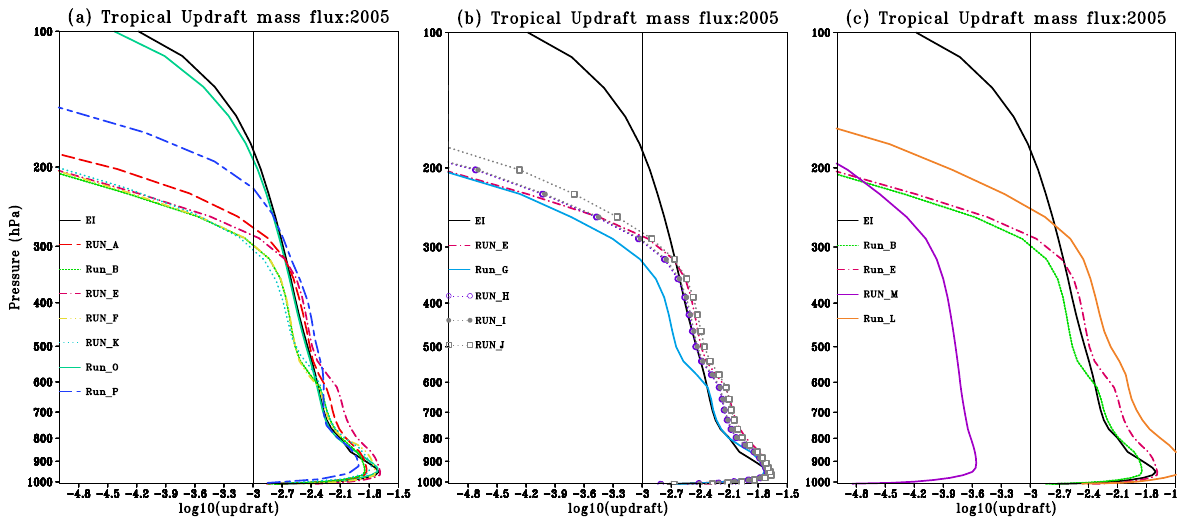
Fig. 7. Zonal mean annual mean tropical (25 ◦ S–25 ◦ N) updraft convective mass flux (kgm − 2 s − 1 ) for 2005 from ERA-Interim reanalyses and (a) runs “A E40”, “B EI”, “E EInewevap”, “F EInewconv”, “K L31”, “N 1991” (December 1990 to January 1991), “O EIar”, “P det”, (b) runs “E EInewevap”, “G 5.6”, “H 1.1”, “I 1.4”, “J T106”, and (c) runs “B EI”, “E EInewevap”, “L 2EVAP”, “M